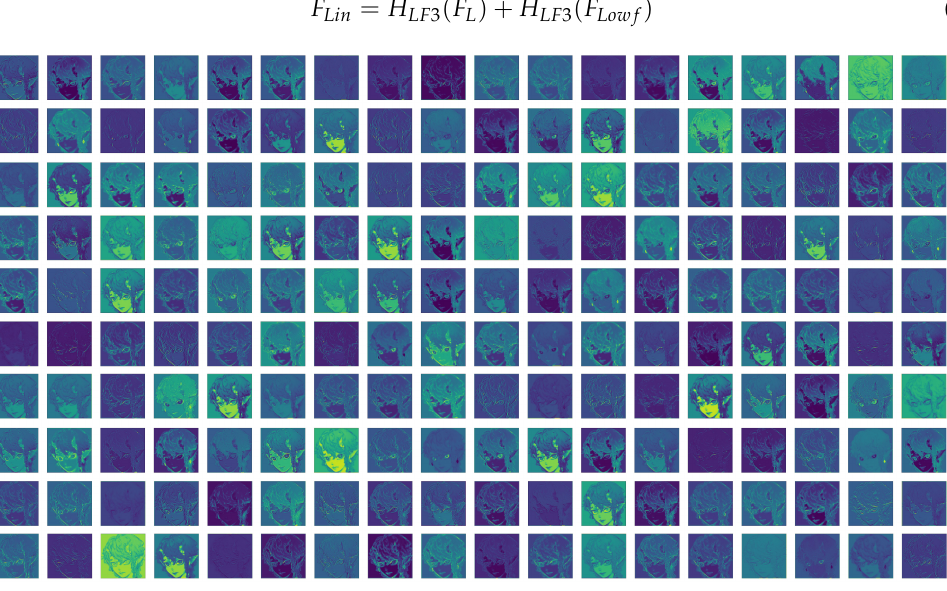
Figure 9. Shallow feature map.